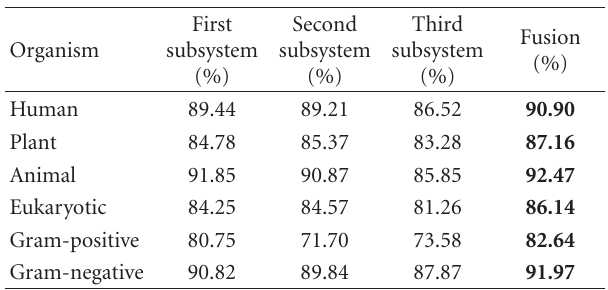
Table 8: The prediction accuracy for secretory proteins from nonsecretory proteins by three subsystems and fusion system.